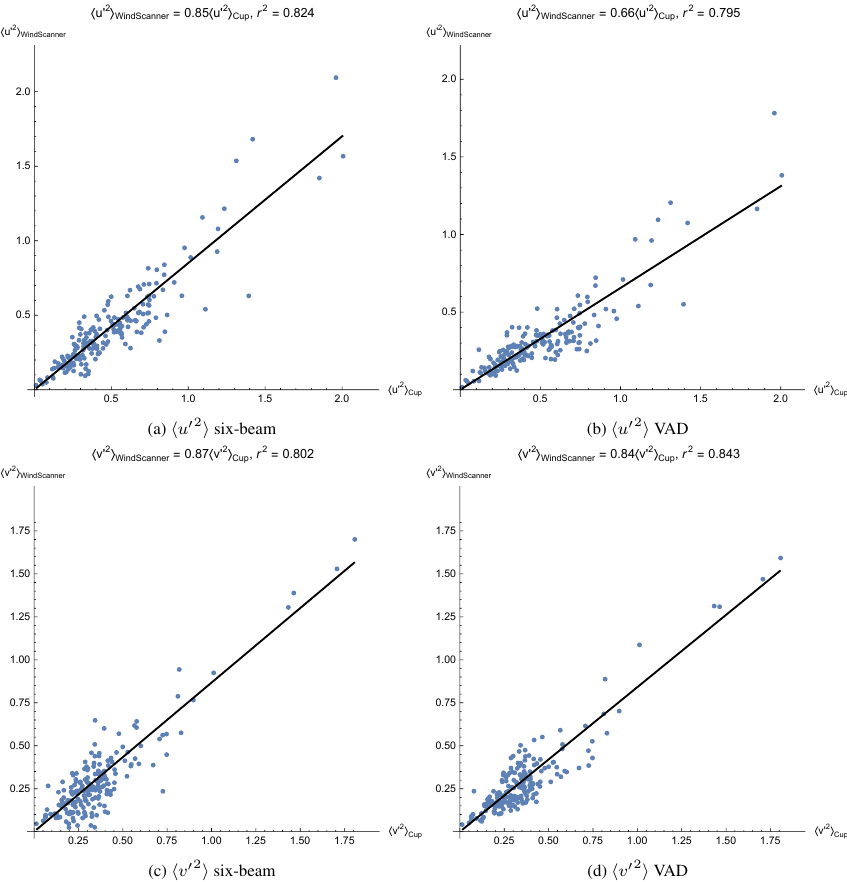
Figure 5. Comparison of the turbulence statistics under unstable conditions between the WindScanner and the cup anemometer using two Fig. 5: Comparison of the the turbulence statistics under unstable conditions between the WindScan- ner and the cup anemometer using two methods to fit the cup anemometer measurements. The scatter using both methods is comparable to each other, but there is a slightly more scatter using the six-beam method for Fig. 6 shows the same as Fig. 5 but under neutral conditions. As for the unstable conditions, the six-beam method measures more turbulence, about 18 % for method. The scatter using both methods is comparable to each other, with the six-beam method giving a slightly reduced scatter than the VAD method.